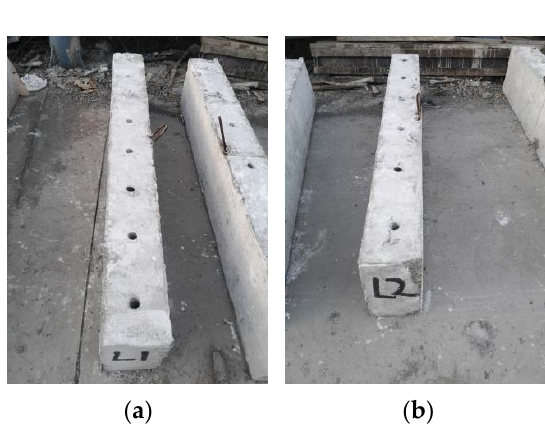
Figure 3. Examples of beams with ( a ) 300 mm and ( b ) 400 mm hole spacing. Table 2. Main design parameters of the specimens.